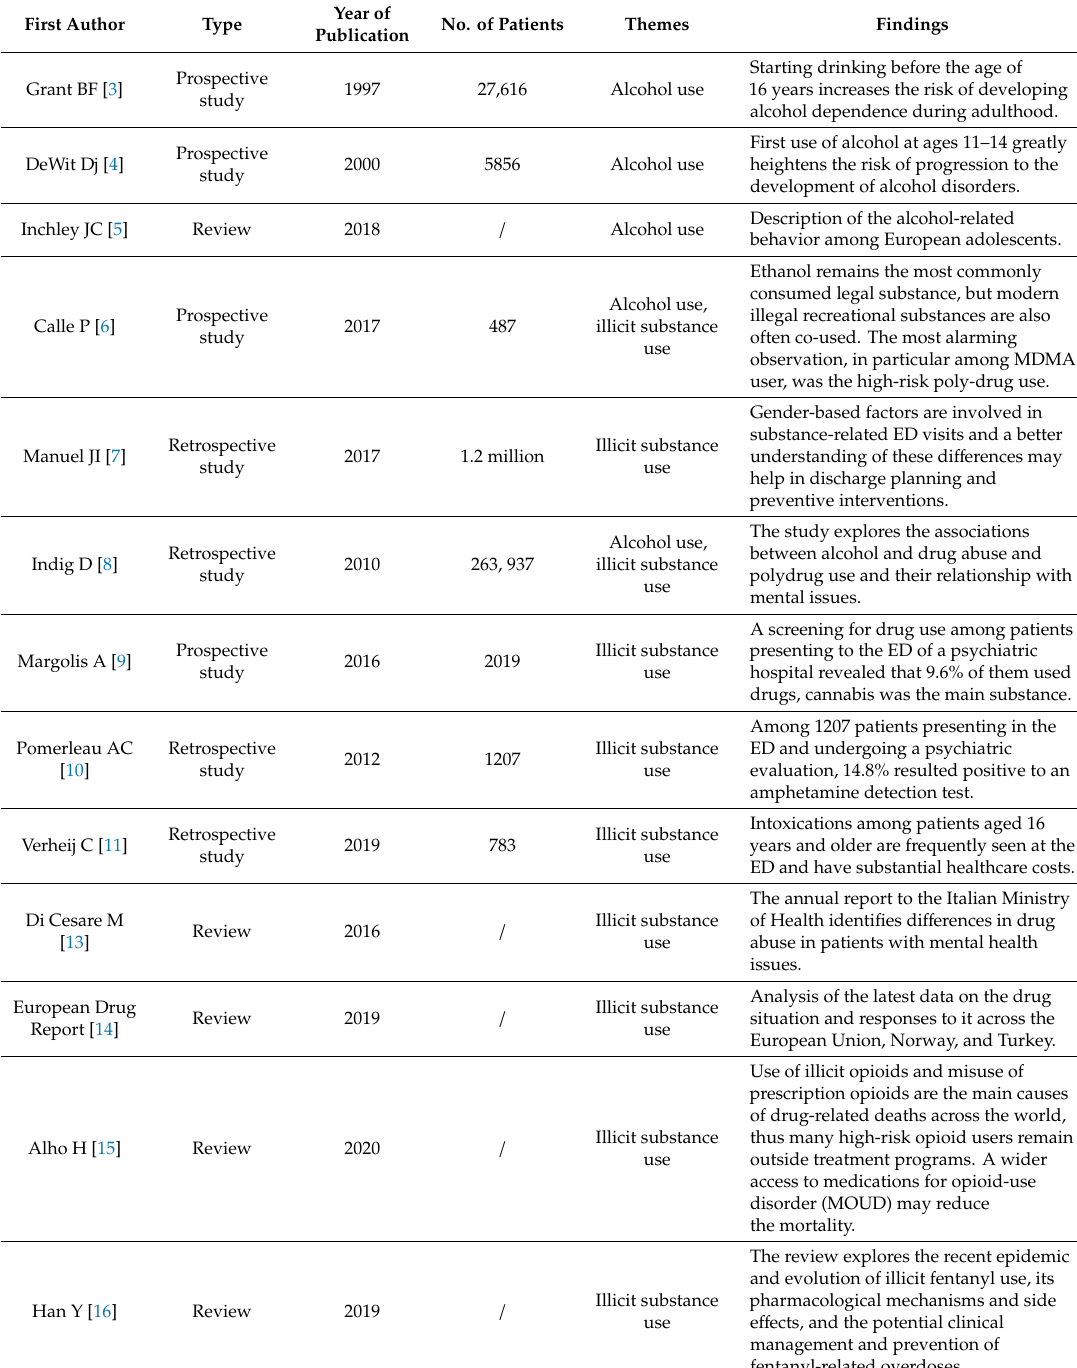
Table 1. List of studies taken into consideration for this narrative